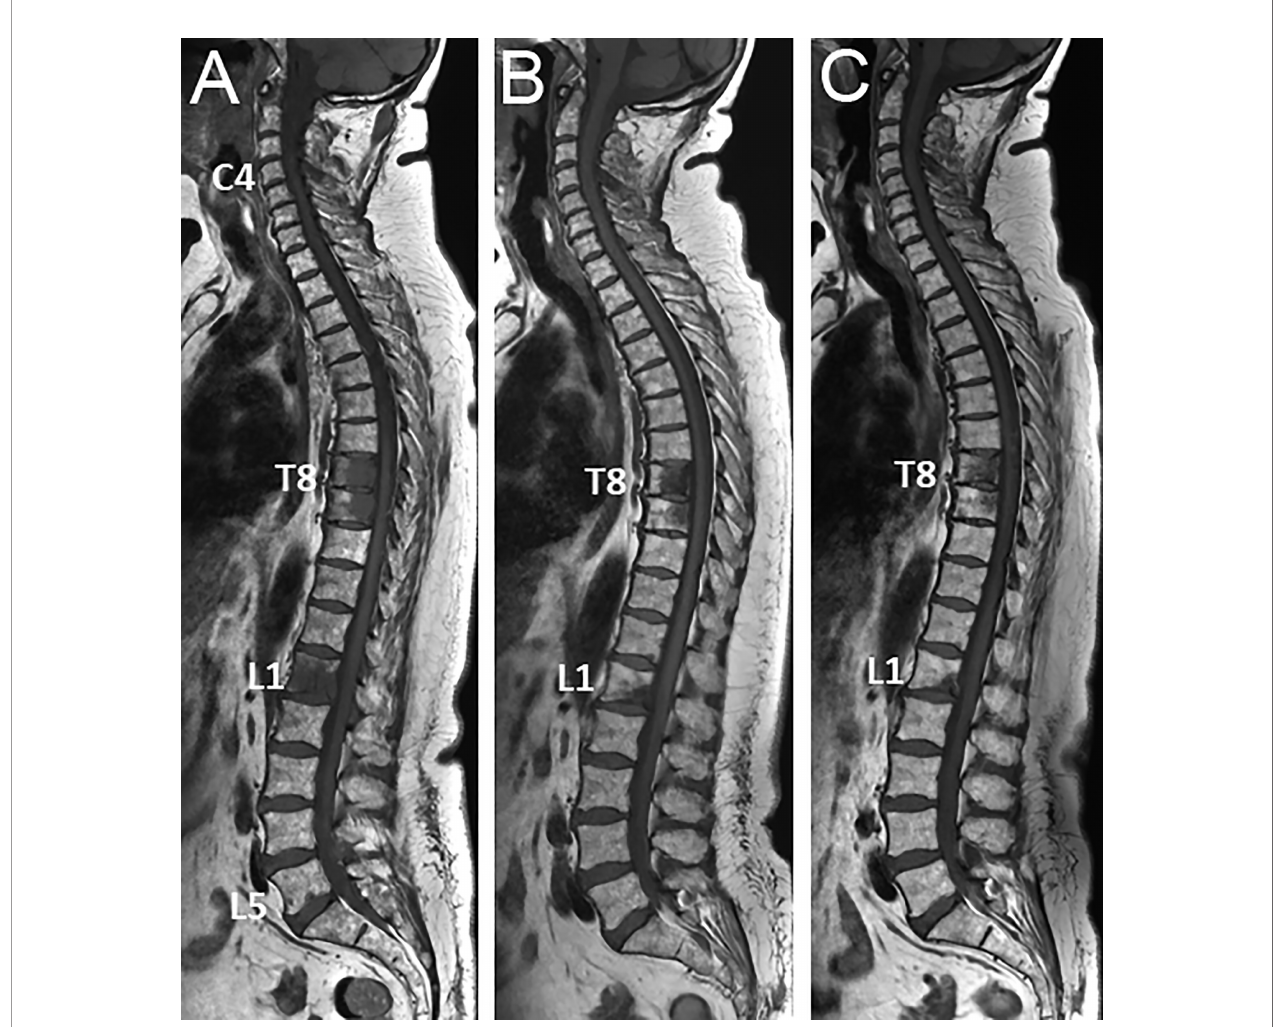
FIGURE 1 | 53 year-old woman with newly diagnosed metastatic breast cancer (grade II ductal carcinoma, ER 8, PR8, KI 67 5%, HER2 neu 2+): spinal MRI fi ndings at diagnosis of bone metastases and during treatment. (A) Baseline sagittal T1-weighted MR image of the whole spine shows multiple foci of low signal intensity of the bone marrow, typical for bone metastases (posterior arch of C4, vertebral bodies of T8, T9, L1, tiny foci in L5). (B) Corresponding MR image obtained 2-m later after combined treatment including a selective estrogen receptor degrader (SERD) and palbociclib shows signi fi cant decrease in size of all lesions, and disappearance of the small L5 foci. (C) Follow-up MR image obtained 2-m later shows further decrease in size of all lesions, with measurable decrease in lesion size and reappearance of fatty marrow at the periphery and within the lesions, again indicating frank response to